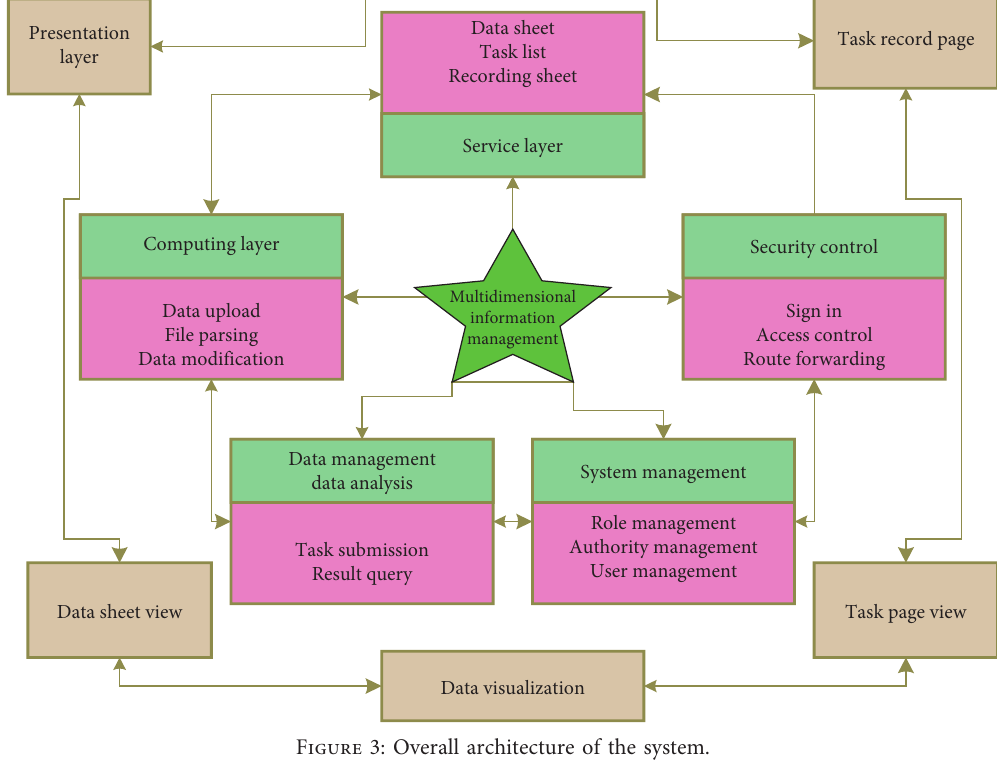
Figure 3: Overall architecture of the system.